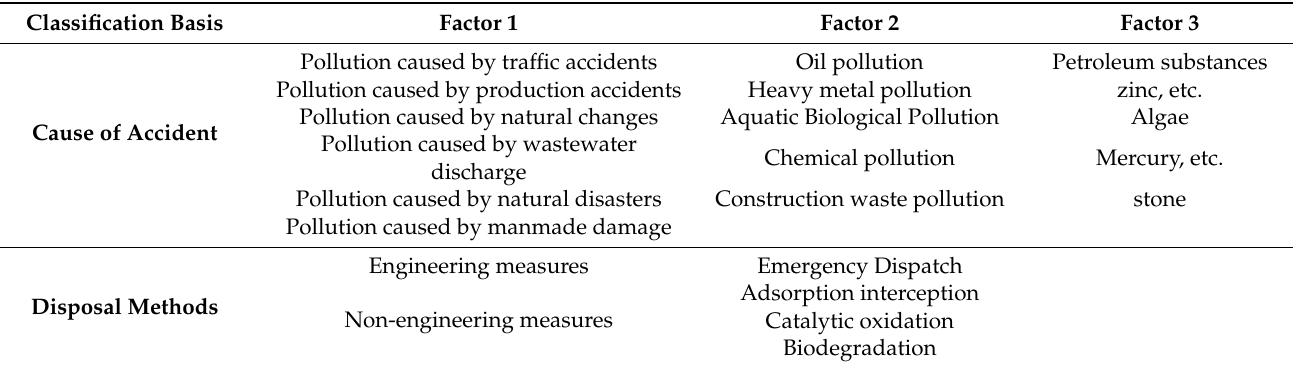
Table 2. Keywords of emergency water